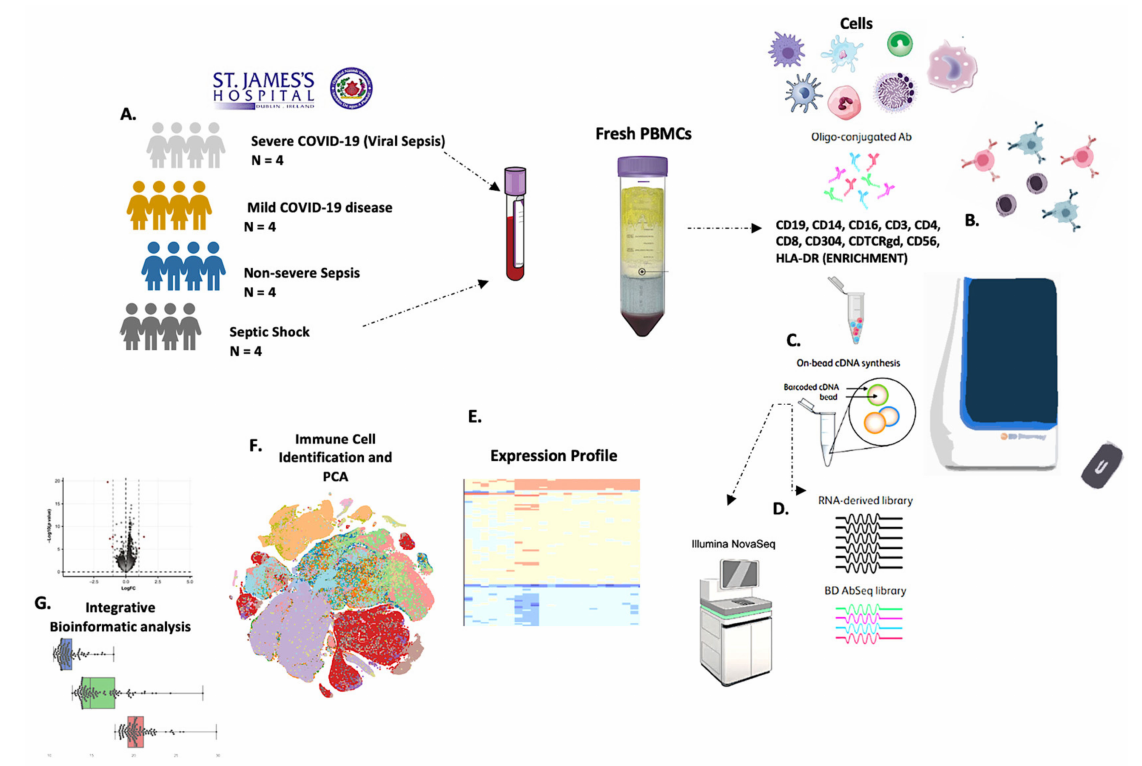
Figure 1. Single-cell transcriptional landscape of severe and non-severe patients with viral and bacterial sepsis and immune cell dysfunction. ( A ) A schematic outline depicting the experimental workflow for data collection from the published literature and the subsequent integrated analysis. Numbers indicate the number of samples of different cohorts (severe COVID-19, mild COVID-19, non-severe sepsis, and septic shock) and expression of 399 transcripts analyzed. ( B ) Specifically, human mononuclear cells were stained with FITC-conjugated antibodies ( CD19 , CD14 , CD16 , CD3 , CD4 , CD8 , CD304 , CDTCRgd , CD56 , and HLA-DR ). ( C ) Single cells isolated using single-cell